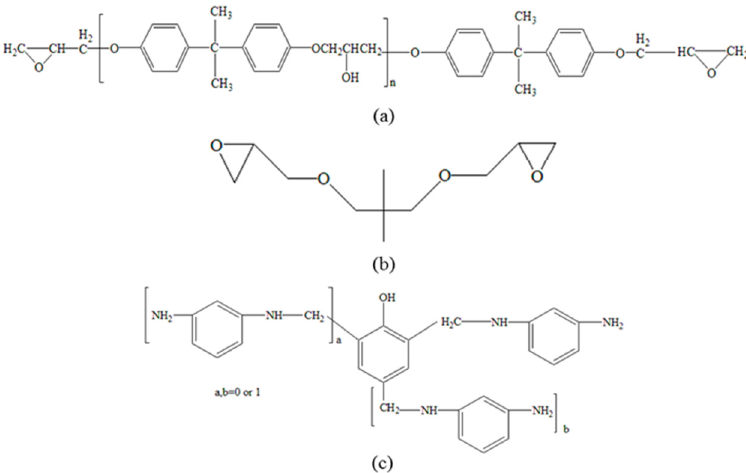
Figure 1. The structures of chemicals: ( a ) Diglycidyl ether of bisphenol A type epoxy resin (DGEBA), ( b ) neopentyl glycol diglycidyl ether (NGDE), and ( c ) phenolic amine 810.